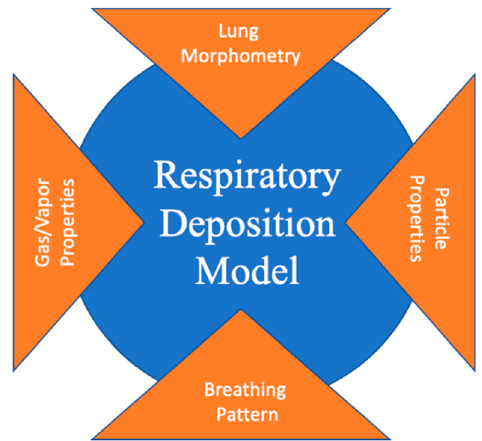
Figure 1. Four types of input data required for a computational aerosol deposition model [4].